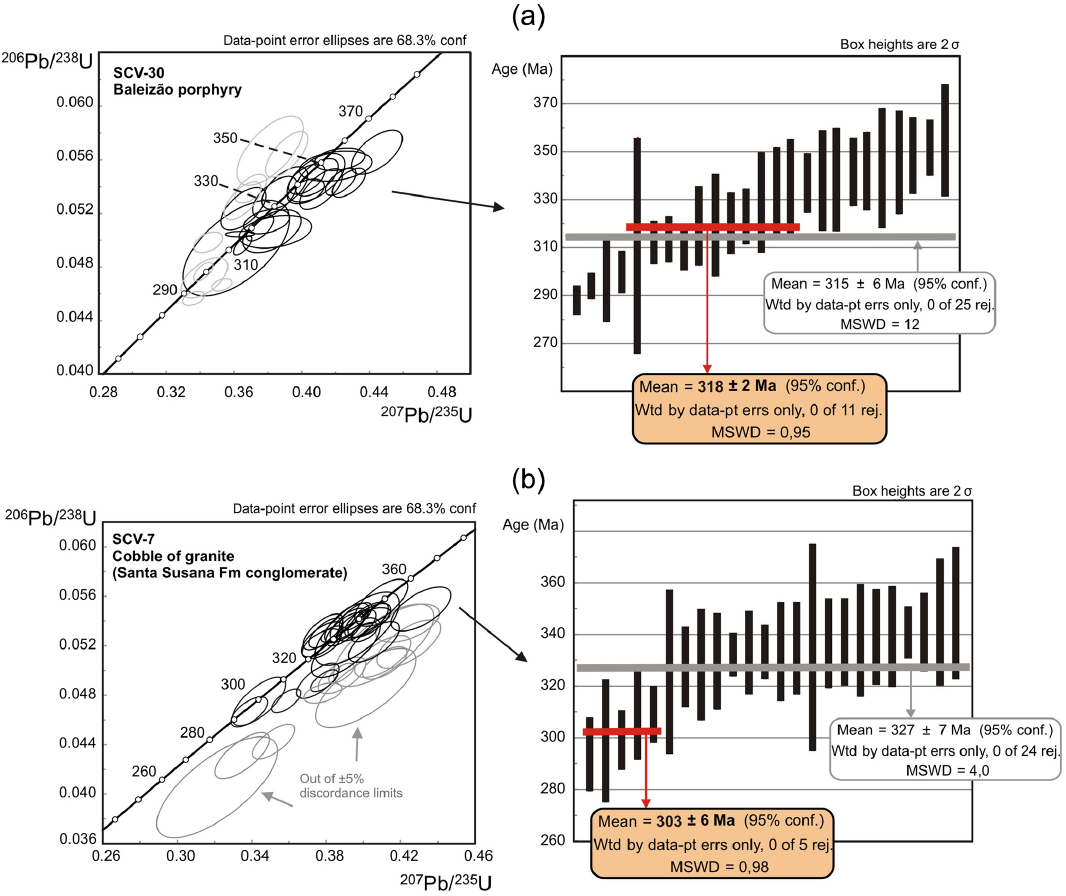
Figure 7. Concordia diagrams and weighted mean of 206 Pb / 238 U ages of analyzed zircon grains of (a) the Baleizão porphyry and (b) the cobble of granite found in conglomerate from the Santa Susana